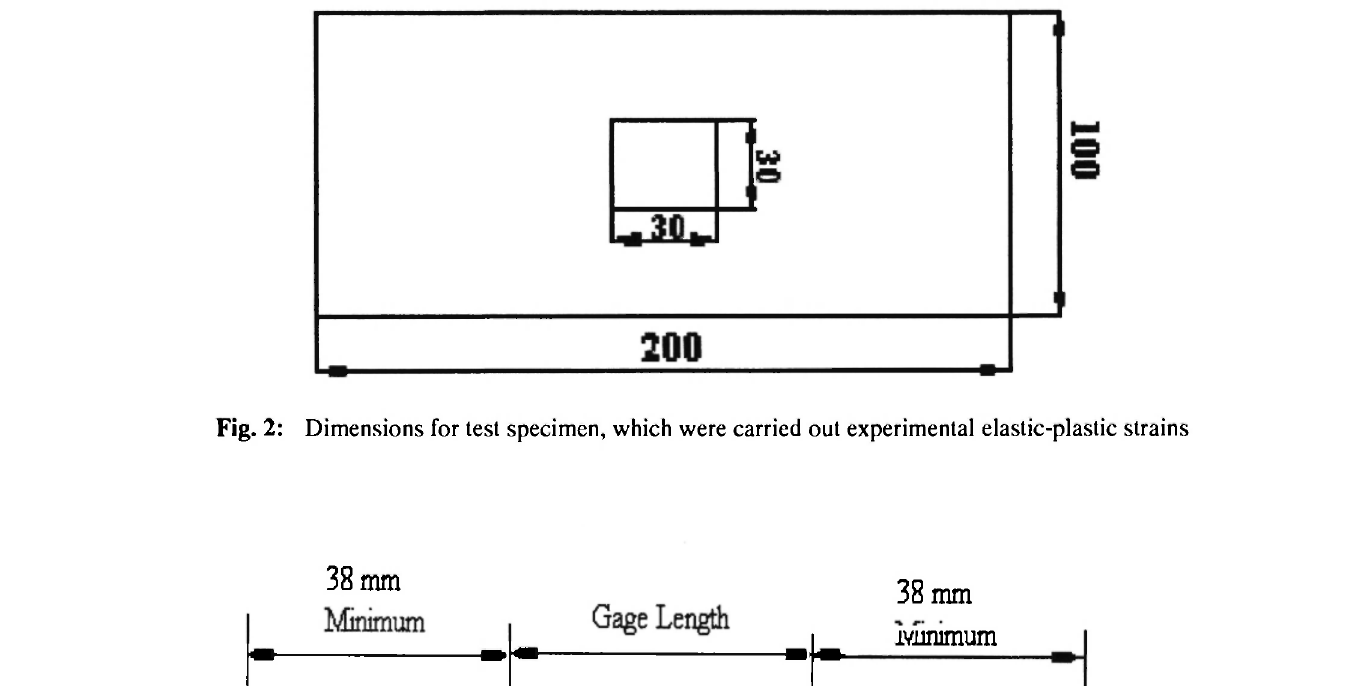
Fig. 3: A typical specimen for tension test of laminated composites, t: Laminate thickness t |i Adhesive thickness t 2 : Tab thickness t 3 : Cut-Off thicknessa: Cut-Off angle L,: Length of tab.